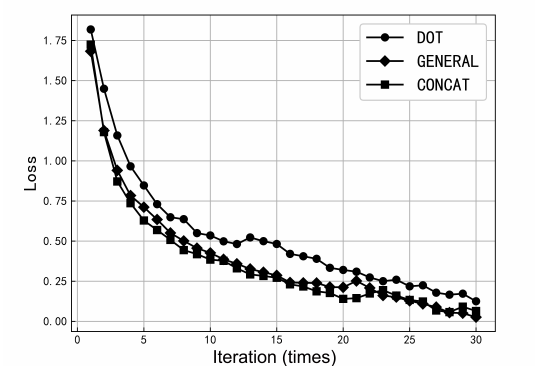
Fig. 5 Loss variation of the attention scoring functions. Table 3 Results of the scoring functions. Scoring function F1-score DOT 77.4 GENERAL 84.2 CONCAT 84.3